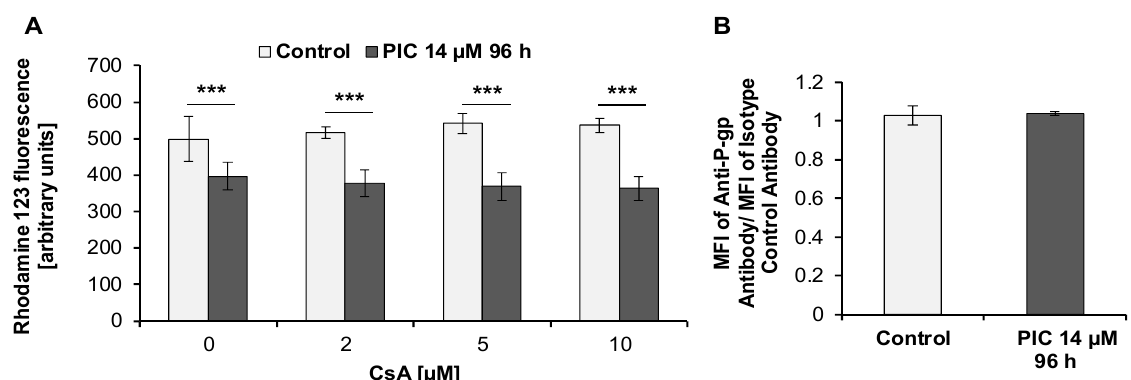
Figure 7. Detection of P-gp in HL-60 cells. Cells were incubated with piceatannol (PIC, IC 90 = 14 µM) for 96 h. ( A ) P-gp activity analysis (flow cytometry analysis). Rhodamine 123 uptake/retention assay was performed in the presence and absence of cyclosporin A (CsA). Data are presented as means ± SD of three independent experiments in duplicates. *** p < 0.001, statistically significant differences between piceatannol-treated cells and untreated cells incubated in the absence or presence of CsA (One-way ANOVA, Tukey’s post hoc analysis). ( B ) Expression of P-gp in HL-60 cells. Control (untreated cells) and piceatannol-treated cells were stained with anti-P-gp (clone UIC2) antibody or isotype control antibody (flow cytometry analysis). Data are presented as means ± SD of three independent experiments in